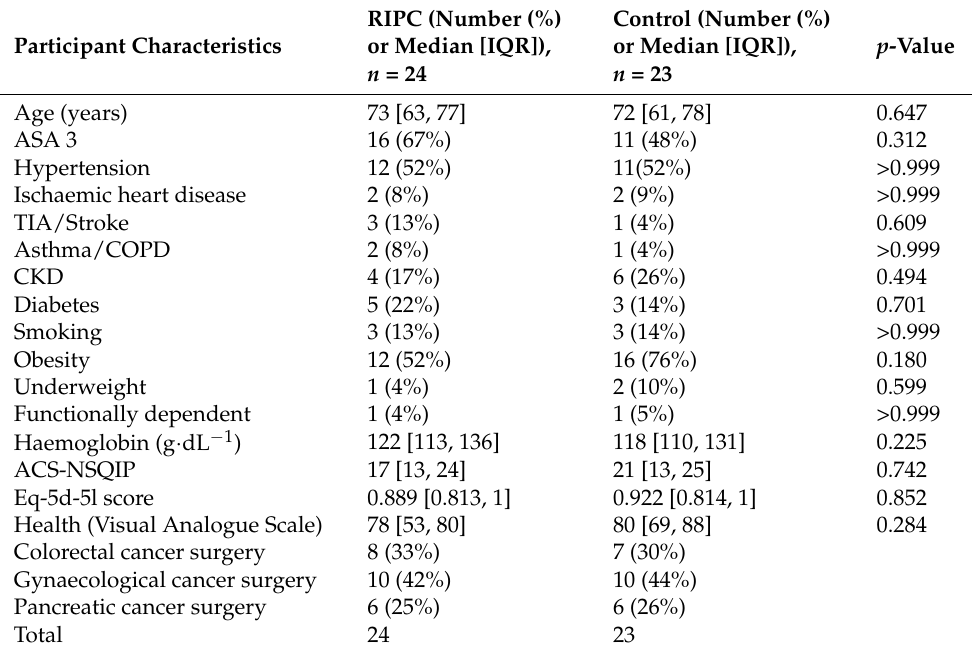
Table 1. Baseline characteristics of participants in the remote ischaemic preconditioning (RIPC) and control groups.